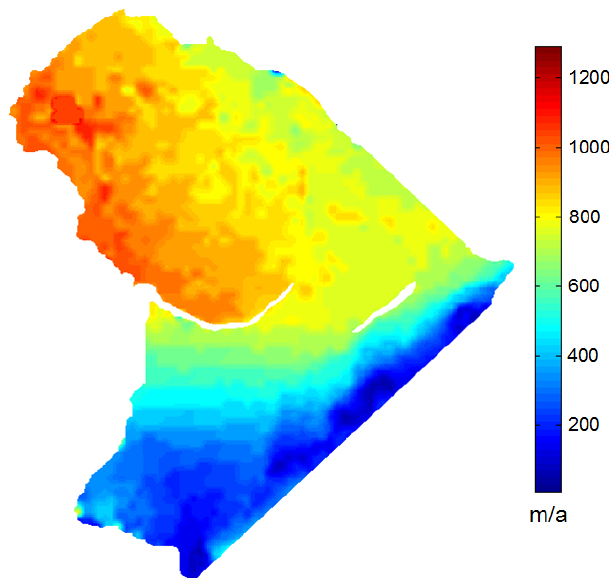
Fig. 8. Speed Profile of SWGT and the BIS. Calculated from NCC